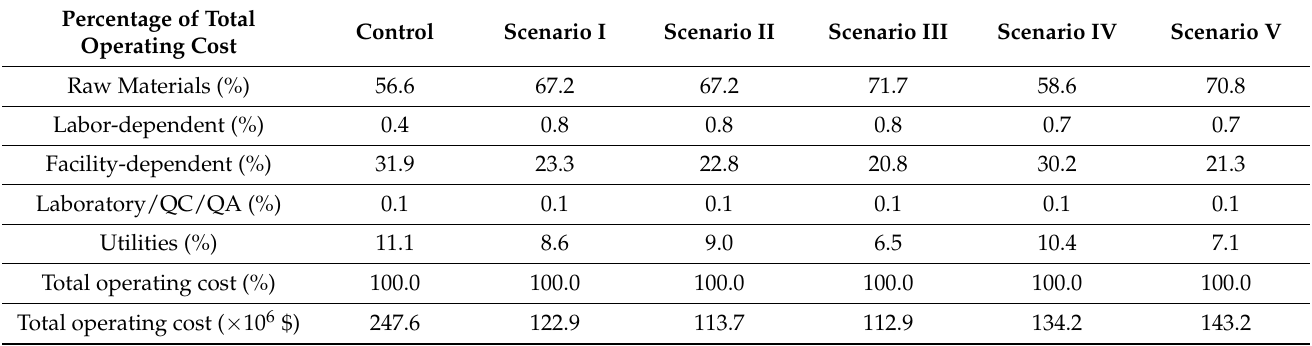
Table 9. Production cost parameters for 2,3-BD fermentation without distillation.